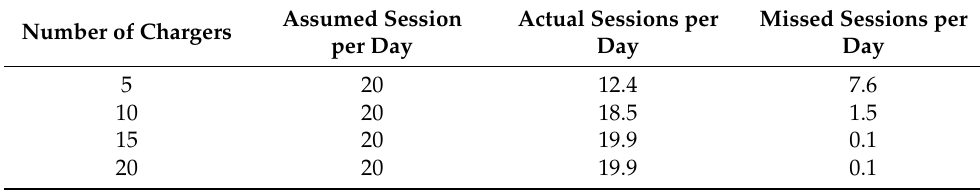
Table 4. Number of chargers selection.